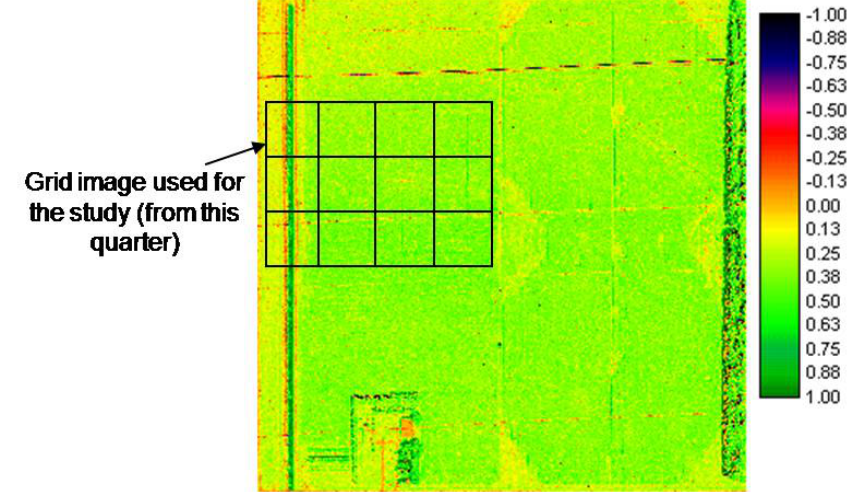
Figure 5. Green vegetation index (GVI) image of the OITA SW16 quarter of